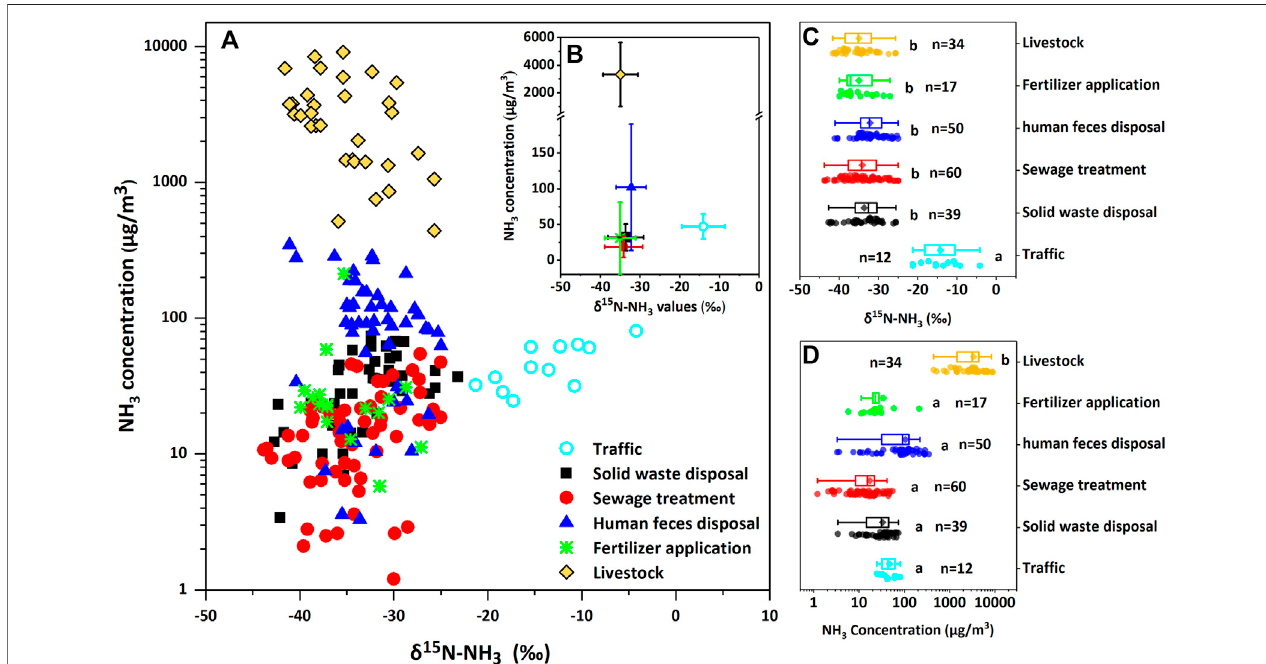
FIGURE 2 | The relationship between NH 3 concentration and δ 15 N-NH 3 values of each source samples in Beijing. (A) shows the δ 15 N-NH 3 values plotted against NH 3 concentration of each source samples. (B) shows the mean δ 15 N-NH 3 values and mean concentration of each sources, error bars indicate standard deviation of each mean. (C,D) are box-plots of δ 15N- values and concentration of each sources respectively, the square and line within the box represent the mean and median valuesof δ 15 N-NH 3 valuesandconcentration,theleftandrightedgesoftheboxrepresentthe25thand75thpercentilesof δ 15 N-NH 3 valuesandconcentration,the left and right bars represent the min and max values, different letters adjacent the bars indicate difference among NH 3 sources ( p < 0.05).